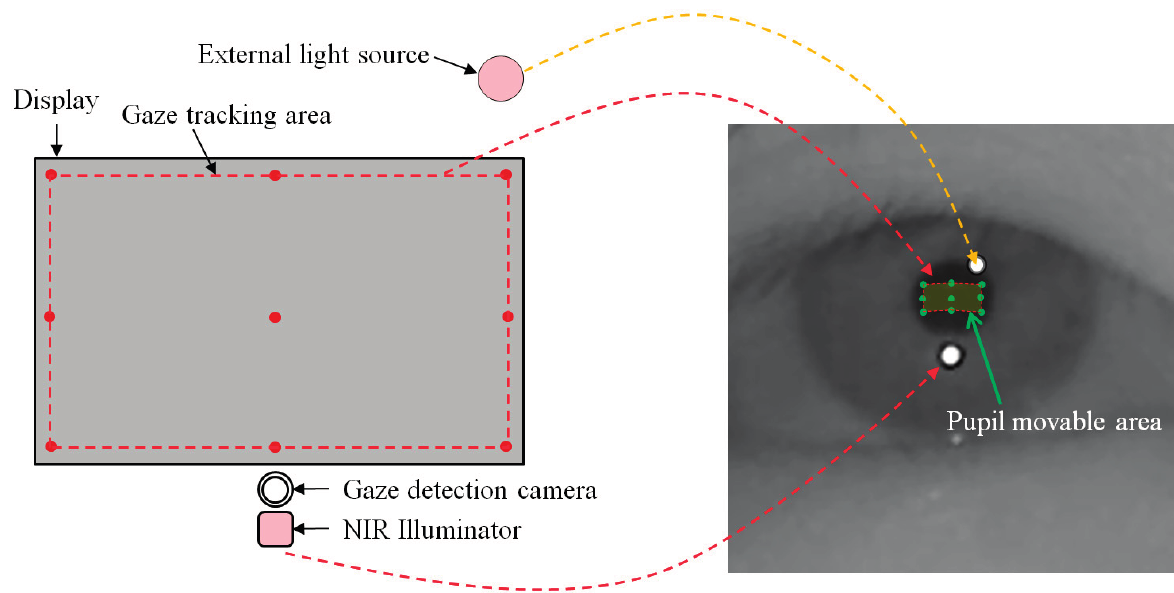
Figure 13. Eye image in presence of external light when using a monitor